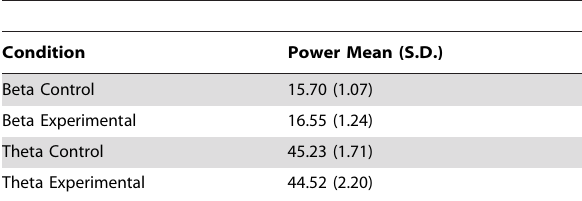
Table 6. Theta Cortical Power Spectral Density by Personality Trait, Trait Score and Condition.